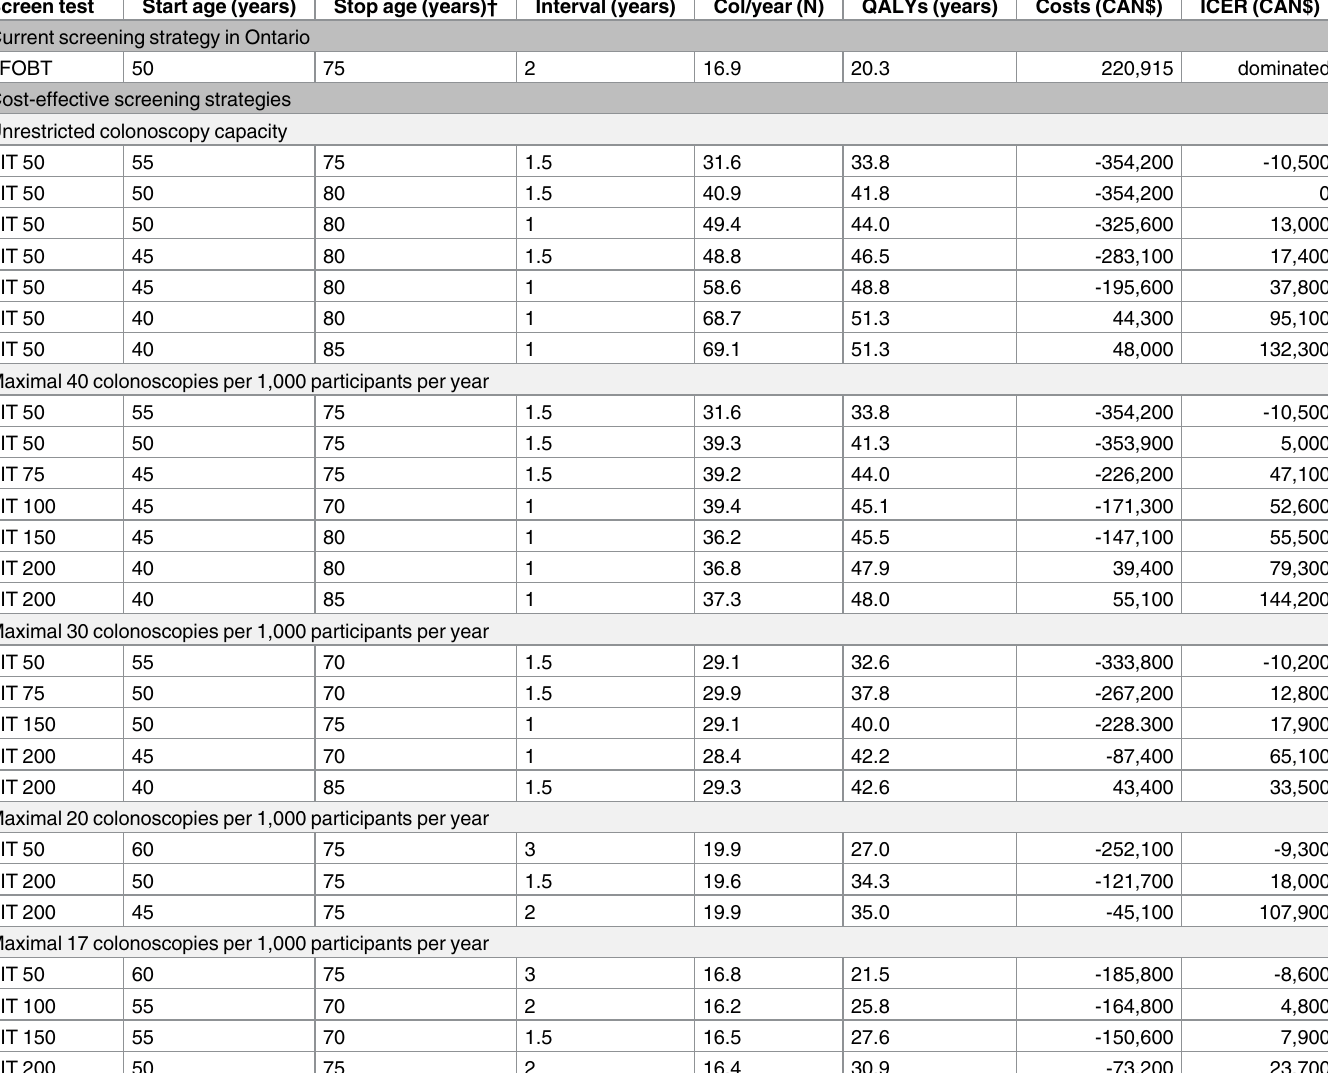
Table 4. Overview of the current gFOBT screening strategyin Ontario, and efficient FIT screening strategies, compared to no screening * . Out- comes per 1,000 participants. Screen